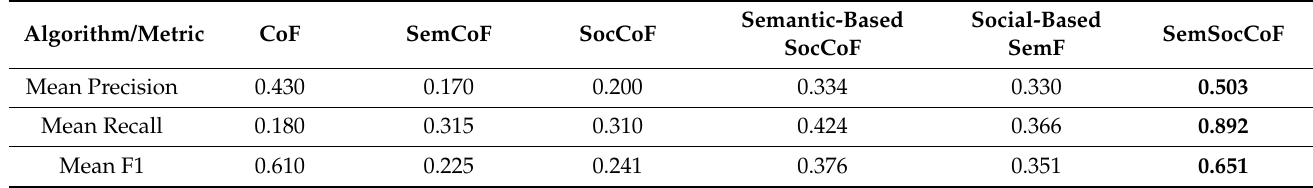
Table 3. Summary of the results obtained by different